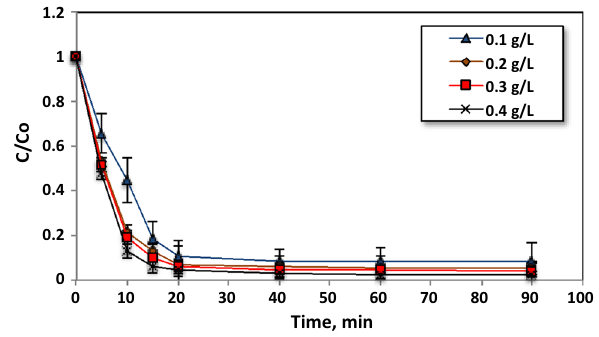
Fig. 4 Effect of ZnO NPs on the photodegradation process